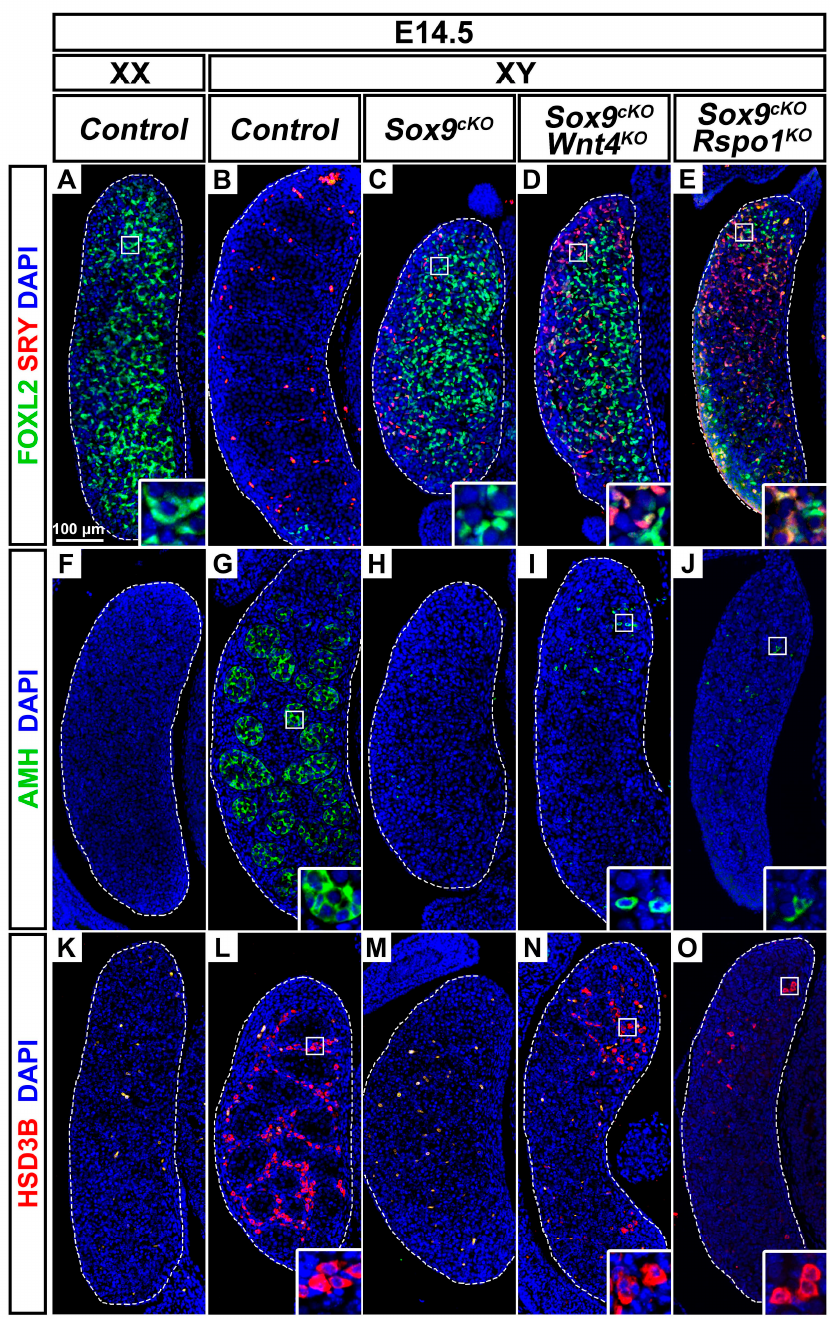
Figure 5. Wnt4 or Rspo1 deletion does not restore testicular development in embryonic XY gonads lacking SOX9 function. ( A – E ) Immunodetection of the pre-granulosa cell marker FOXL2 (green) and the male supporting cell marker SRY (red) in E14.5 gonads of XX Control ( A ), XY Control ( B ), XY Sox9 cKO ( C ), XY Sox9 cKO Wnt4 KO ( D ), and XY Sox9 cKO Rspo1 KO ( E ) genotypes. ( F – J ) Immunodetection of the Sertoli cell marker AMH (green) in E14.5 gonads of XX Control ( F ), XY Control ( G ), XY Sox9 cKO ( H ), XY Sox9 cKO Wnt4 KO ( I ), and XY Sox9 cKO Rspo1 KO ( J ) genotypes. ( K – O ) Immunodetection of the steroidogenic enzyme HSD3B (red) in E14.5 gonads of XX Control ( K ), XY Control ( L ), XY Sox9 cKO ( M ), XY Sox9 cKO Wnt4 KO ( N ), and XY Sox9 cKO Rspo1 KO ( O ) genotypes. Nuclei labeled with DAPI are shown in blue. Magnification is the same in all panels. Scale bar = 100 µm. Gonads are outlined with broken white lines.